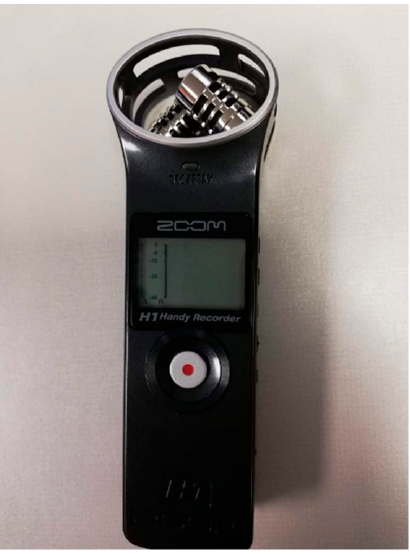
Figure 3. Audio recorder used to collect